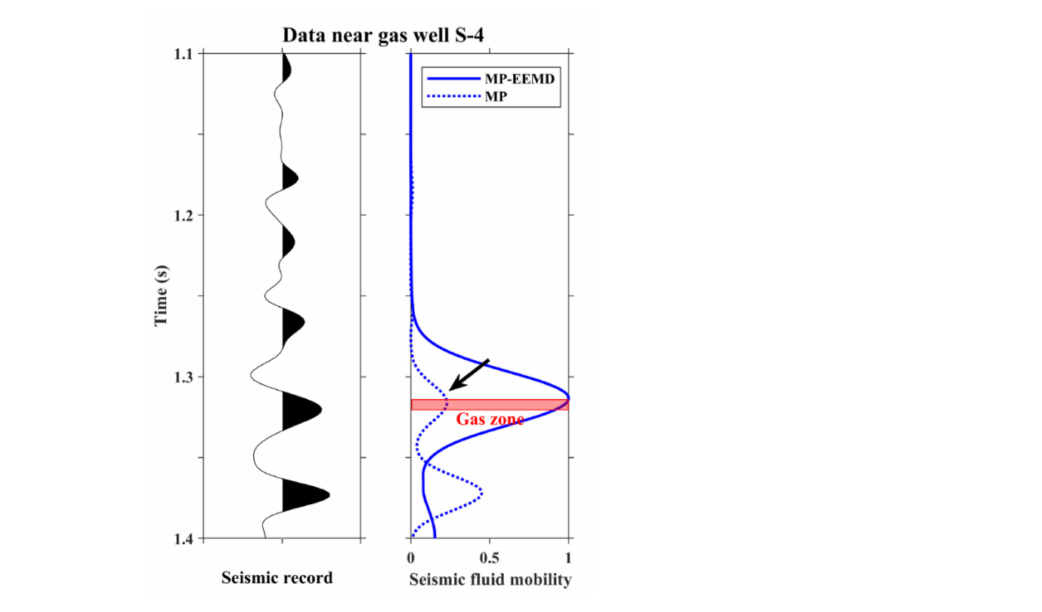
Figure 9. Seismic record ( left ) ad seismic fluid mobility attribute ( right ) near gas well S-4. According to the results of well-seismic calibration, the gas zone in well S-4 (depth 2748.3–2761.3 m) is located at time 1.313–1.319 s (red